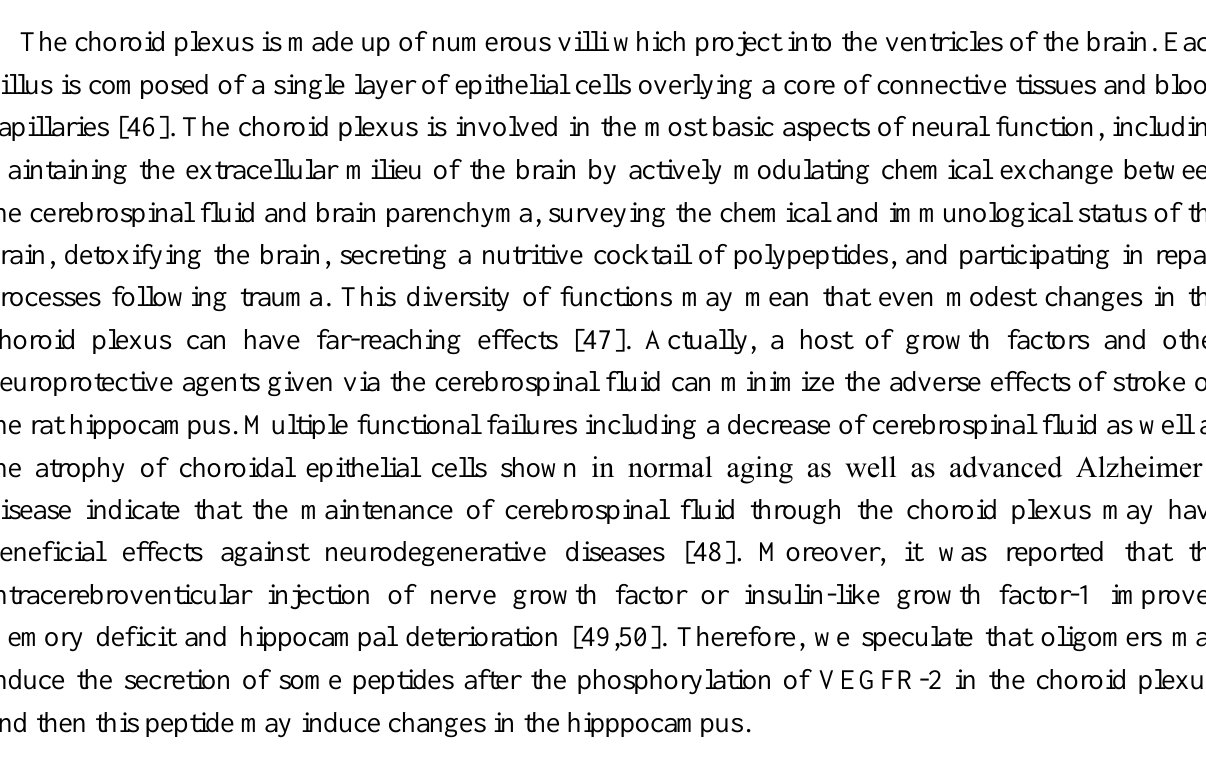
Figure 9. Effects of oligomers on phosphorylated VEGFR-2 (p-VEGFR-2) and VEGFR-2 expressions. Fifty-nine-week-old SAMP8 were administered vehicle (Veh, water p.o.) or oligomers (O (50), 50 mg/kg body weight/day, p.o.). After seven days of administration, brain lysates were immunoblotted with antibodies for p-VEGFR-2 ( A ) or VEGFR-2 ( B ). Expression intensities were divided by  -actin expressions to calculate ratios. a p = 0.0481 vs. O (50) (Student’s t